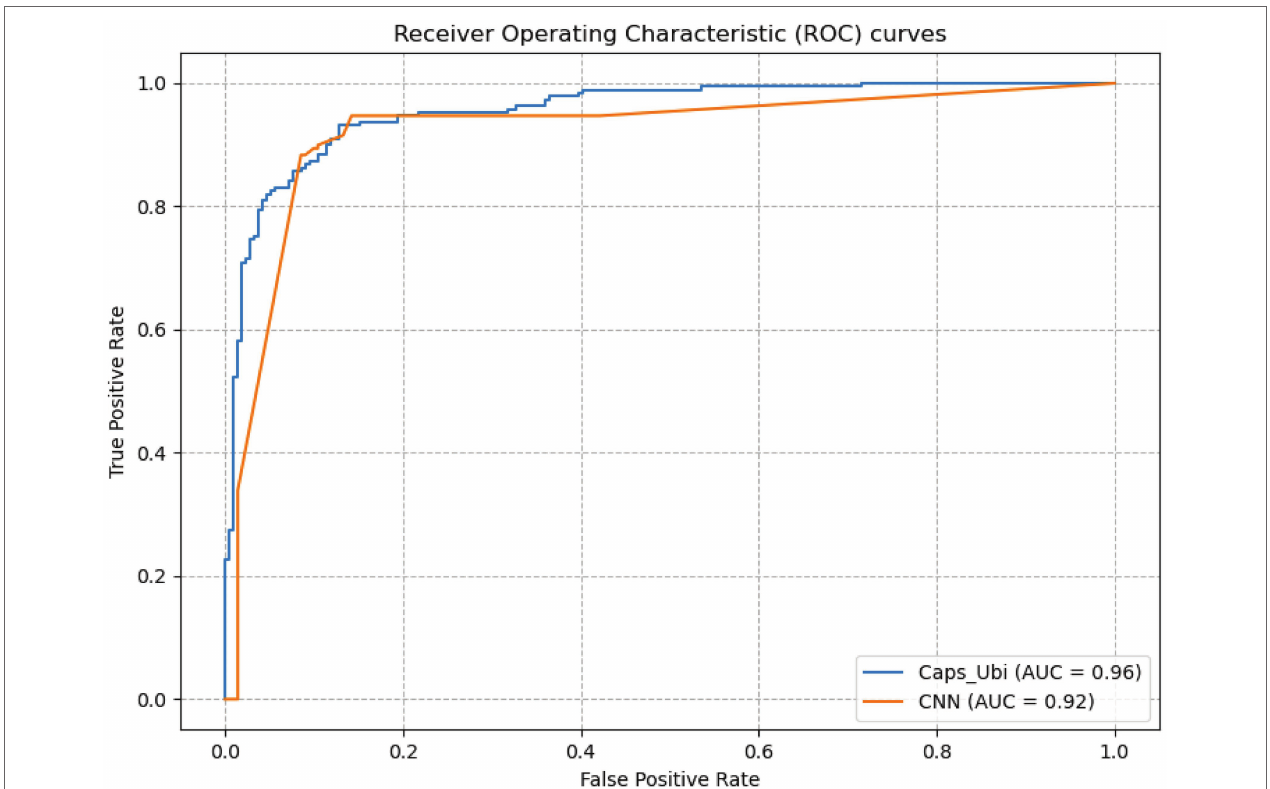
FIGURE 4 | Receiver operating characteristic curve of Caps-Ubi and CNN on the test set.